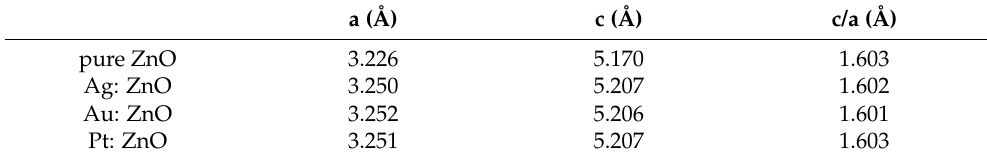
Table 2. Comparison of the calculated lattice constants a and c with the respected c/a ratio.